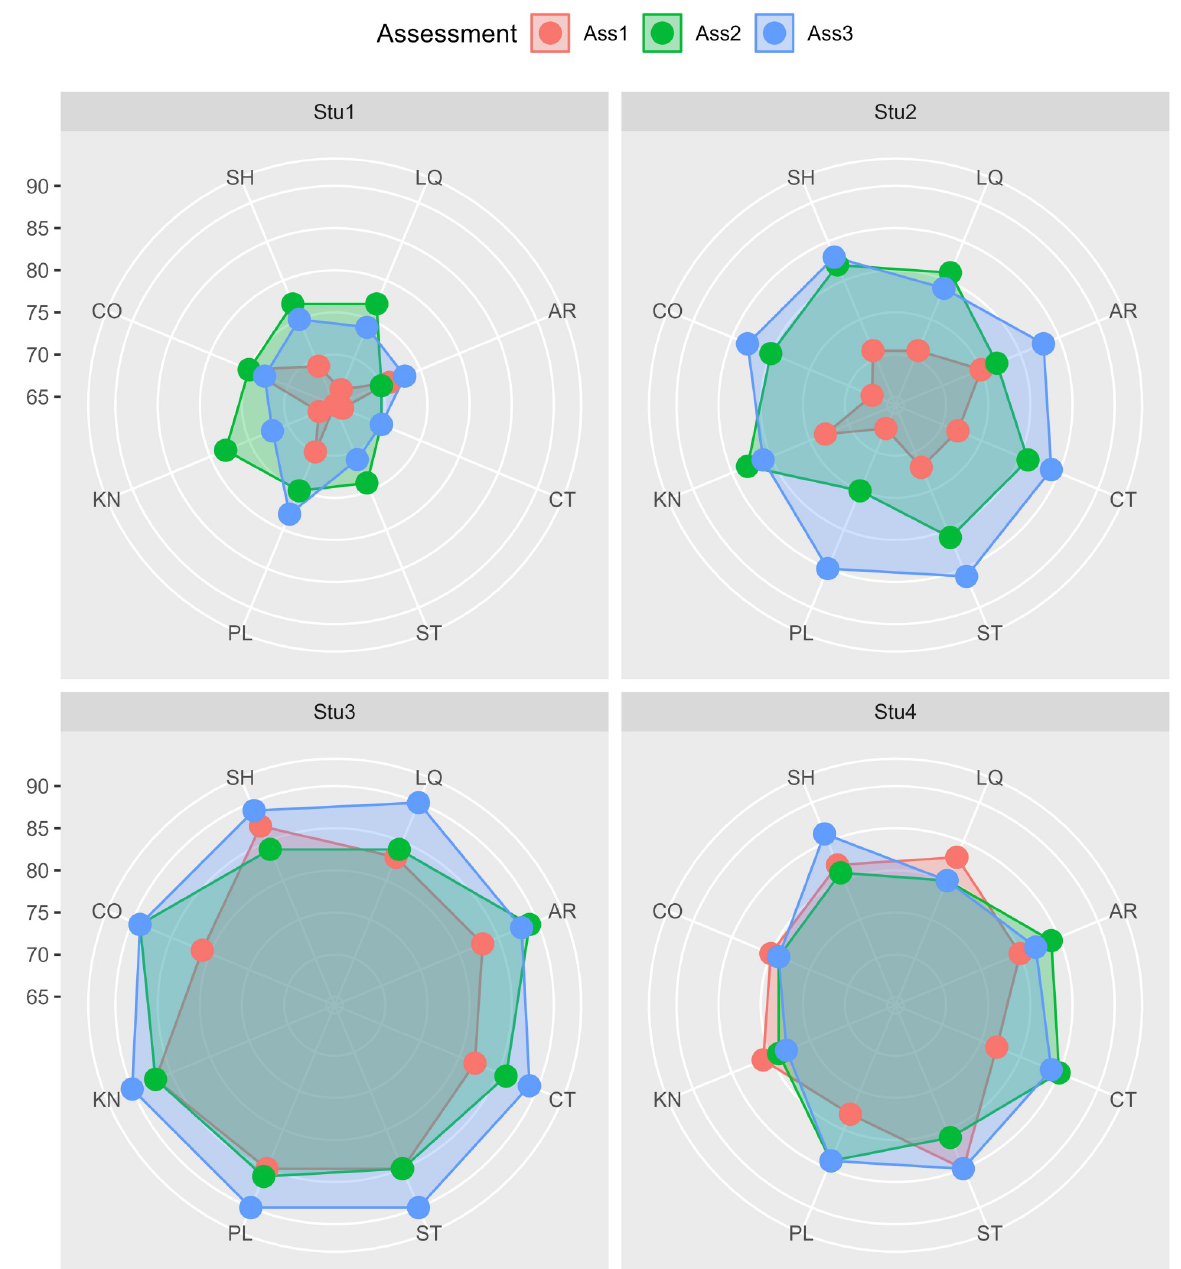
Fig 4. Grade changes of four students in three assessments. The interpreting competences assessed included: Stress Handling (SH), Language Quality (LQ), Accuracy (AR), Creativity (CT), Succinctness (ST), Paralinguistics (PL), Knowledge (KN), and Correction (CO).